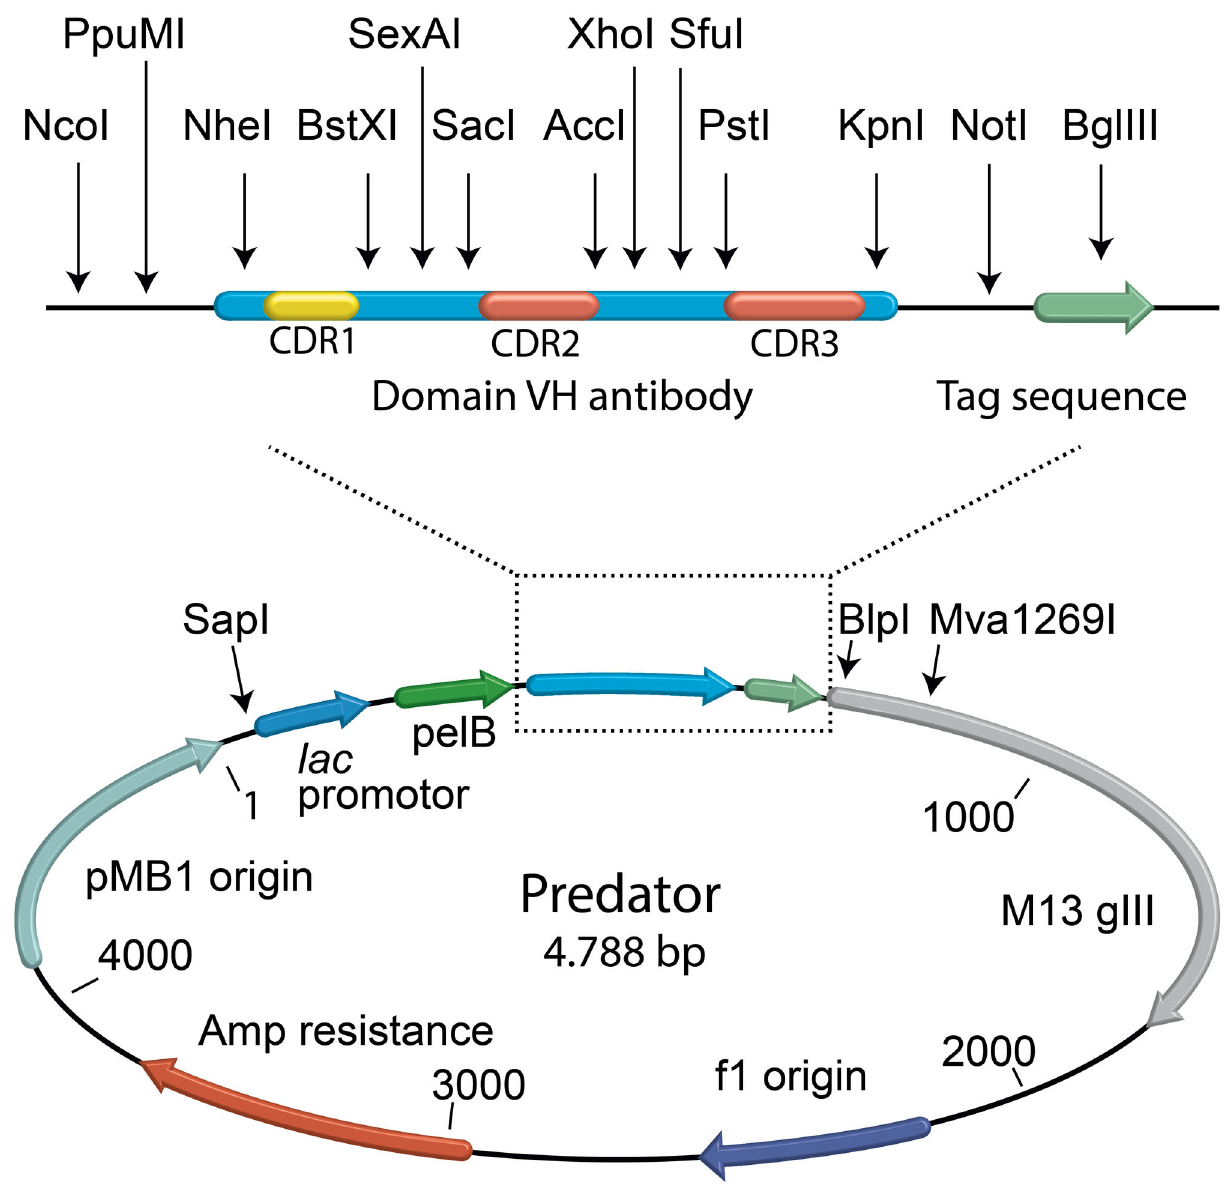
Figure 2. Vector map of the Predator library. The Predator vector map with the most important components marked. At the top of the figure an enlargement of the antibody region with the unique restriction sites and cassettes surrounding the CDR loops is